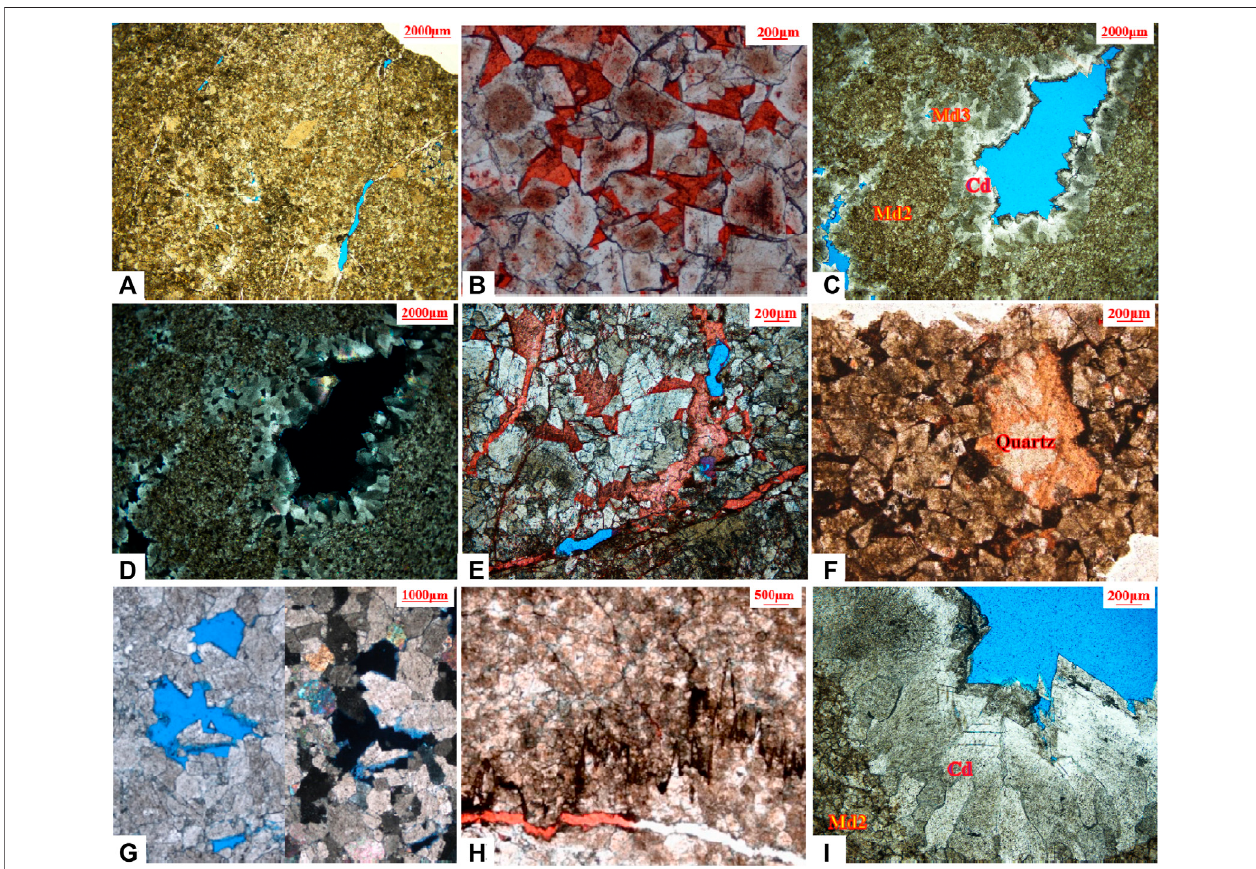
FIGURE4| Photosshowingpetrographicalcharacteristicsofdifferentdolomites. (A) Very fi nelyto fi nelycrystallineMd1withresidualbioclasticstructureand early- stagedissolutionvugsandmicrofracturepreserved(SampleZC-5); (B) Idiomorphic-hypidiomorphiccrystallineMd2withcloudy-coreandclear-rim(SampleK2-2406.5); (C) Cd fi lling in the dissolved pores close to the Md2 and Md3 (Sample XJG-3-2); (D) cross-polarized photomicrograph of (C) , Cd showing sharp undulatory extinction; (E) massivevugsandmicrofractureofMd3are fi lledwithcalcitecementsandbitumen(SampleHS1-4996); (F) Md3withdissolvedpores fi lledbyauthigenicquartz and calcite cements (Sample HS1-4977.9); (G) Md3 of coarsely to medium crystalline, nonplanar-a texture, and turbid crystals without clear rims, and the right half shows a sharp undulatory extinction under cross-polarized light (Sample HJL-10); (H) stylolites fi lled with bitumen-cut Md3 crystals and were later cut by microfracture fi lled with calcite cements (Sample HJL-13); (I) different-stage Cd fi lling in the hydraulic fracture close to the Md2 (Sample ZC-16).